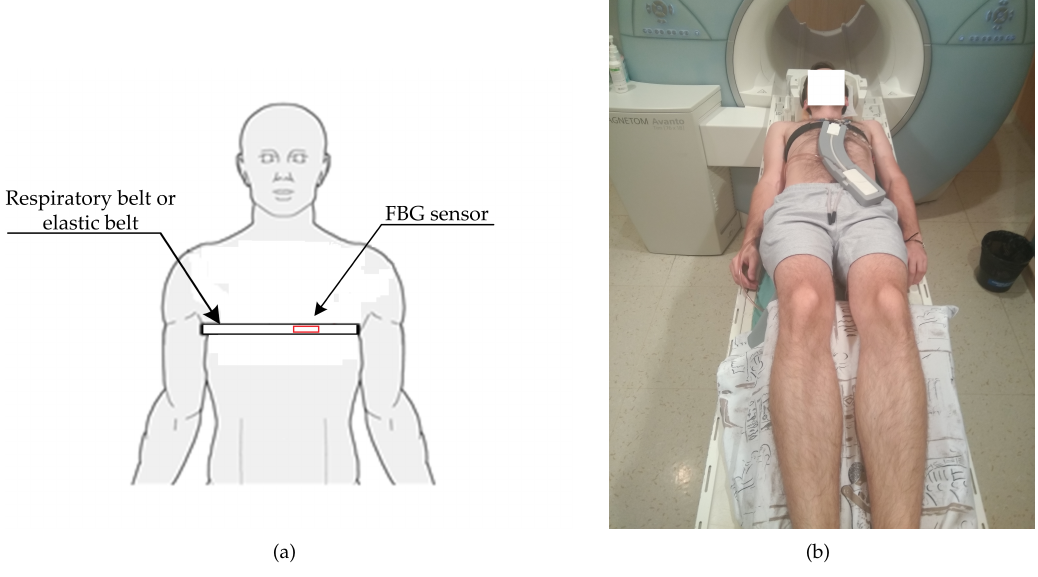
Figure 9. ( a ) a schematic location of the FBG sensor on the human body; ( b ) a photo taken during a real measurement (test subject